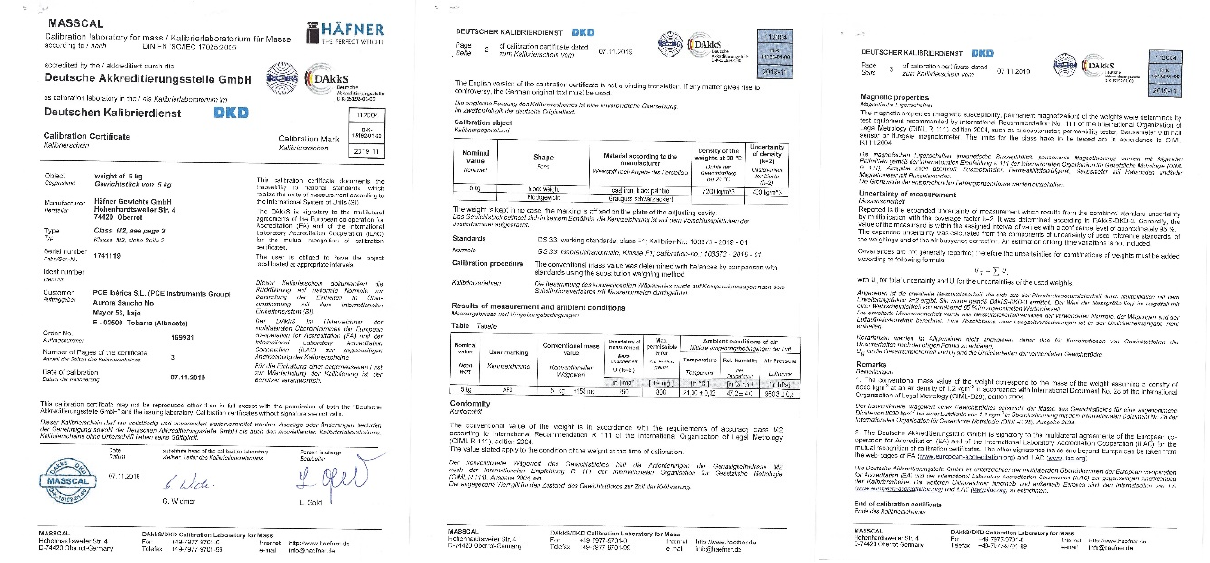
Figure A1. Calibration Certificate Document.